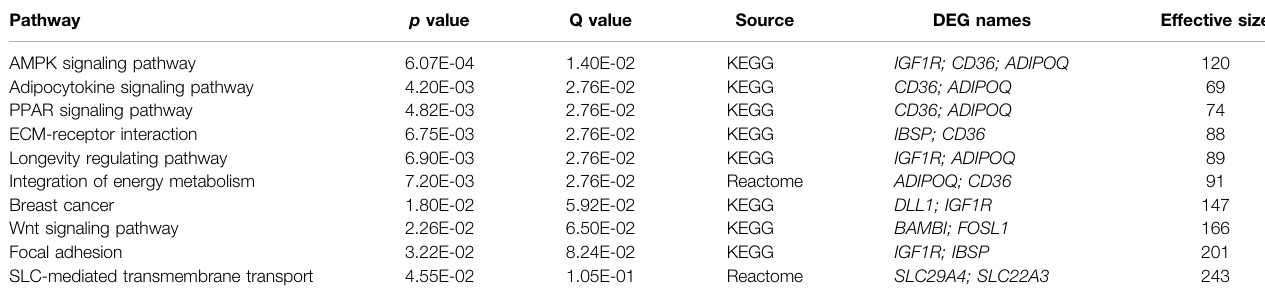
TABLE 3 | Top DEG Pathways in LPS/VILI-exposed rats: ALT-100 mAb-treated versus PBS.